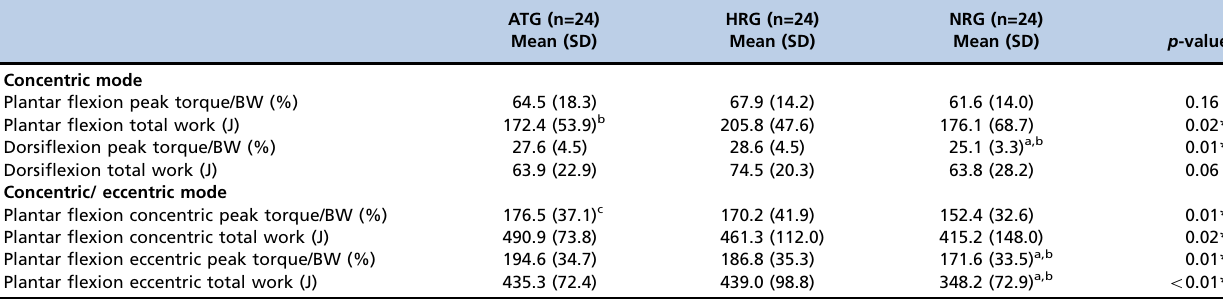
post-hoc test, * p p 0.05). Table 4 - Test results for the hypothesis of equality of the means of isokinetic variables at 120 o /sec.